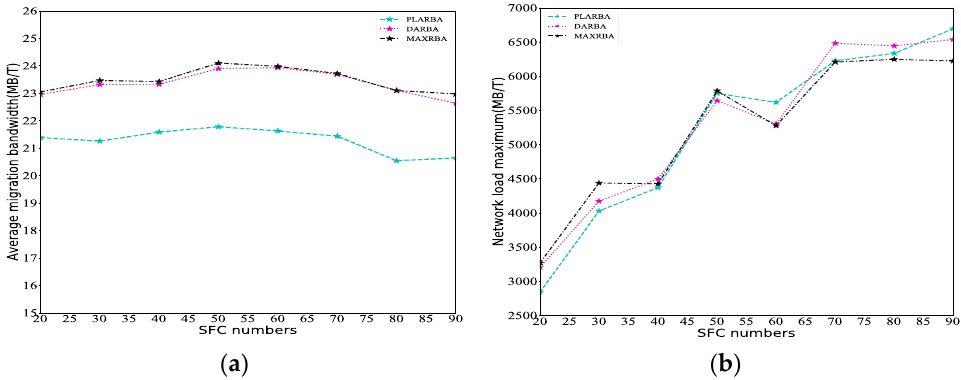
Figure 8. Occupied bandwidth resources with respect to SFC numbers: ( a ) average migration bandwidth; ( b ) network load maximum.